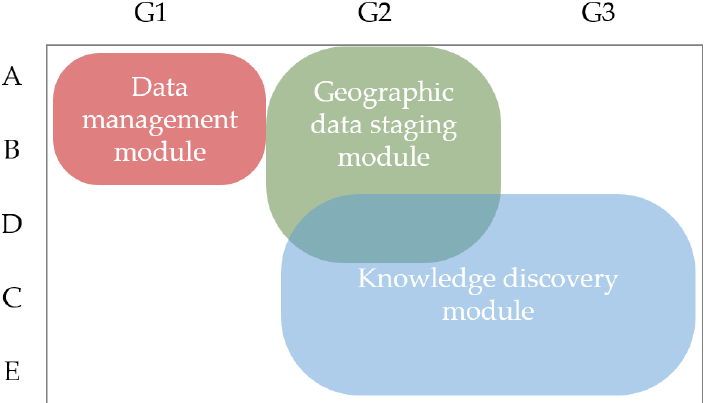
Figure 1. How Data and Knowledge Platform (DKP) modules cover climate-service features and initial